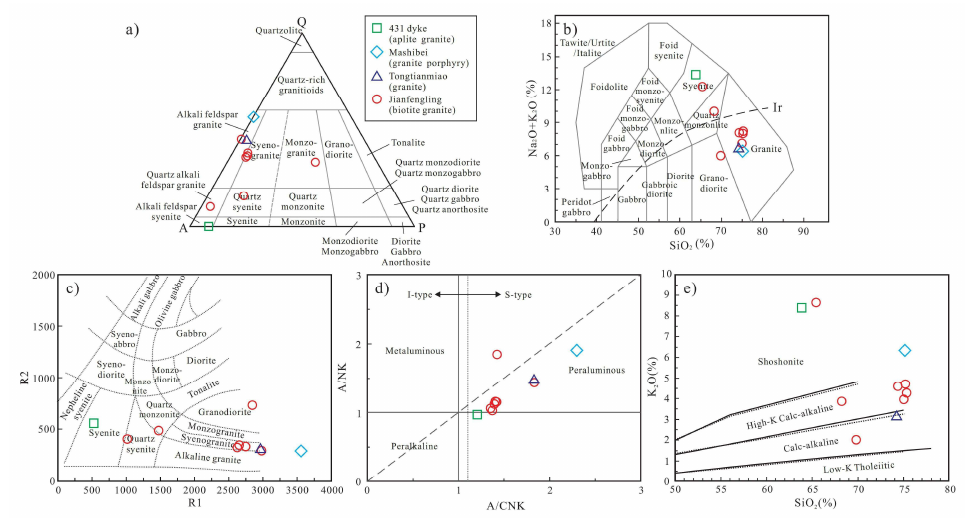
Figure 6. Classification diagram of granite in the Xianghualing ore field. ( a ) QAP diagram [33]; ( b ) TAS diagram [34]; ( c ) R1 vs. R2 diagram [35]; ( d ) A/CNK vs. A/NK diagram [36]; ( e ) SiO 2 vs. K 2 O diagram [37].